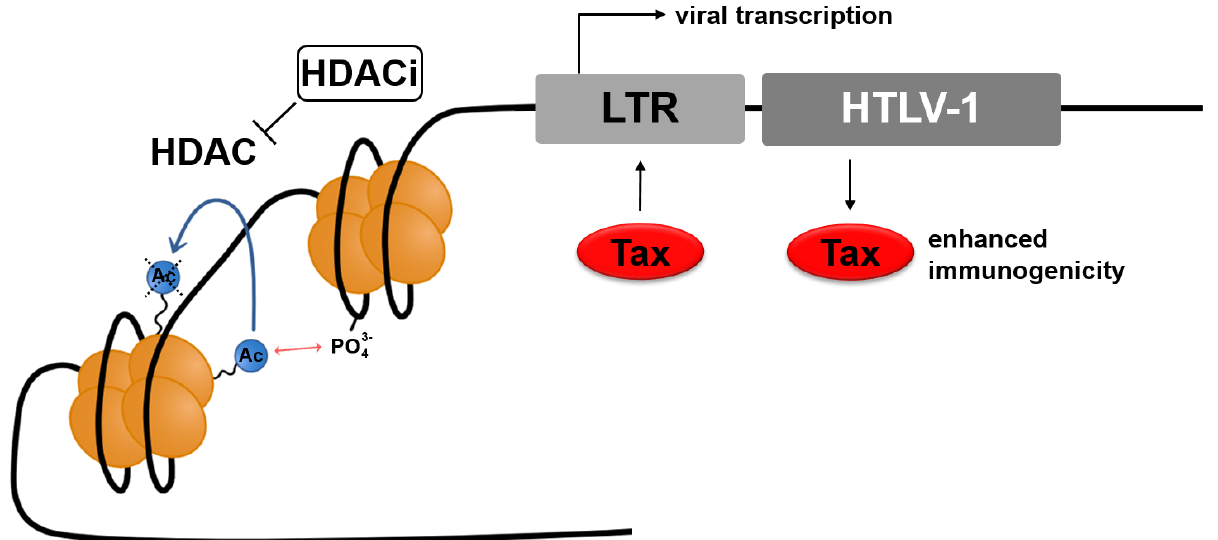
Figure 2. Mode of action of histone deacetylase inhibitors (HDACi) as latency reversing agents for HTLV-1. Epigenetic modifications govern transcription of the integrated HTLV-1 genome. Inhibition of histone deacetylases (HDACs) by histone deacetylase inhibitors (HDACi) raises acetylation of histone tails, thereby decreasing their affinity to chromatin. This results in a more permissive chromatin state, favoring transcriptional activation. Thus, the latent viral reservoir can be reactivated more easily. Abbreviations: HDAC, histone deacetylase; HDACi, histone deacetylase inhibitor; LTR, long terminal repeat; HTLV-1, Human T-cell leukemia virus type 1; Ac, acetylated lysine residue; PO 3 − phosphate 4